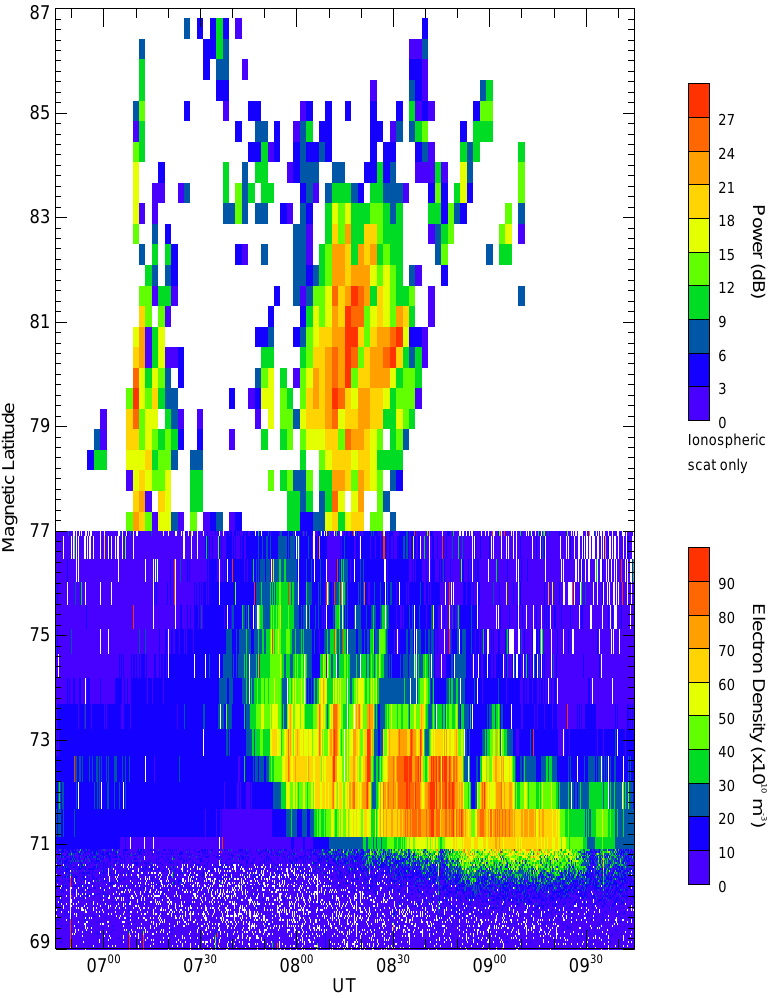
Fig. 7. Composite plot of backscattered power from beam 7 of the CUTLASS Finland radar and electron density from beam 1 of the EISCAT VHF radar, as a function of magnetic latitude between 0645 and 09:45UT on 23 November 1999. Observations below 77 ◦ are from the VHF radar and those above, from the Finland